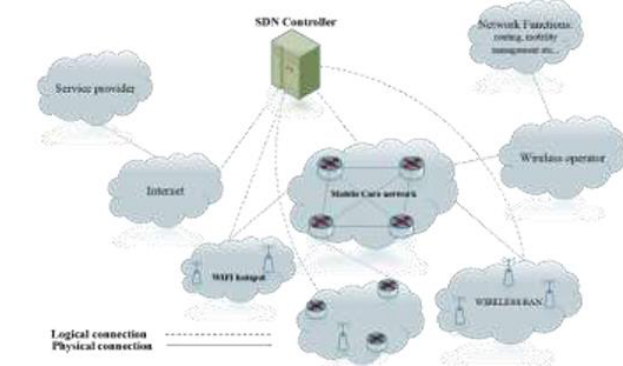
Fig. 1. SDN based cellular network architecture showing different networks coordinate with SDN controller and communicate with each